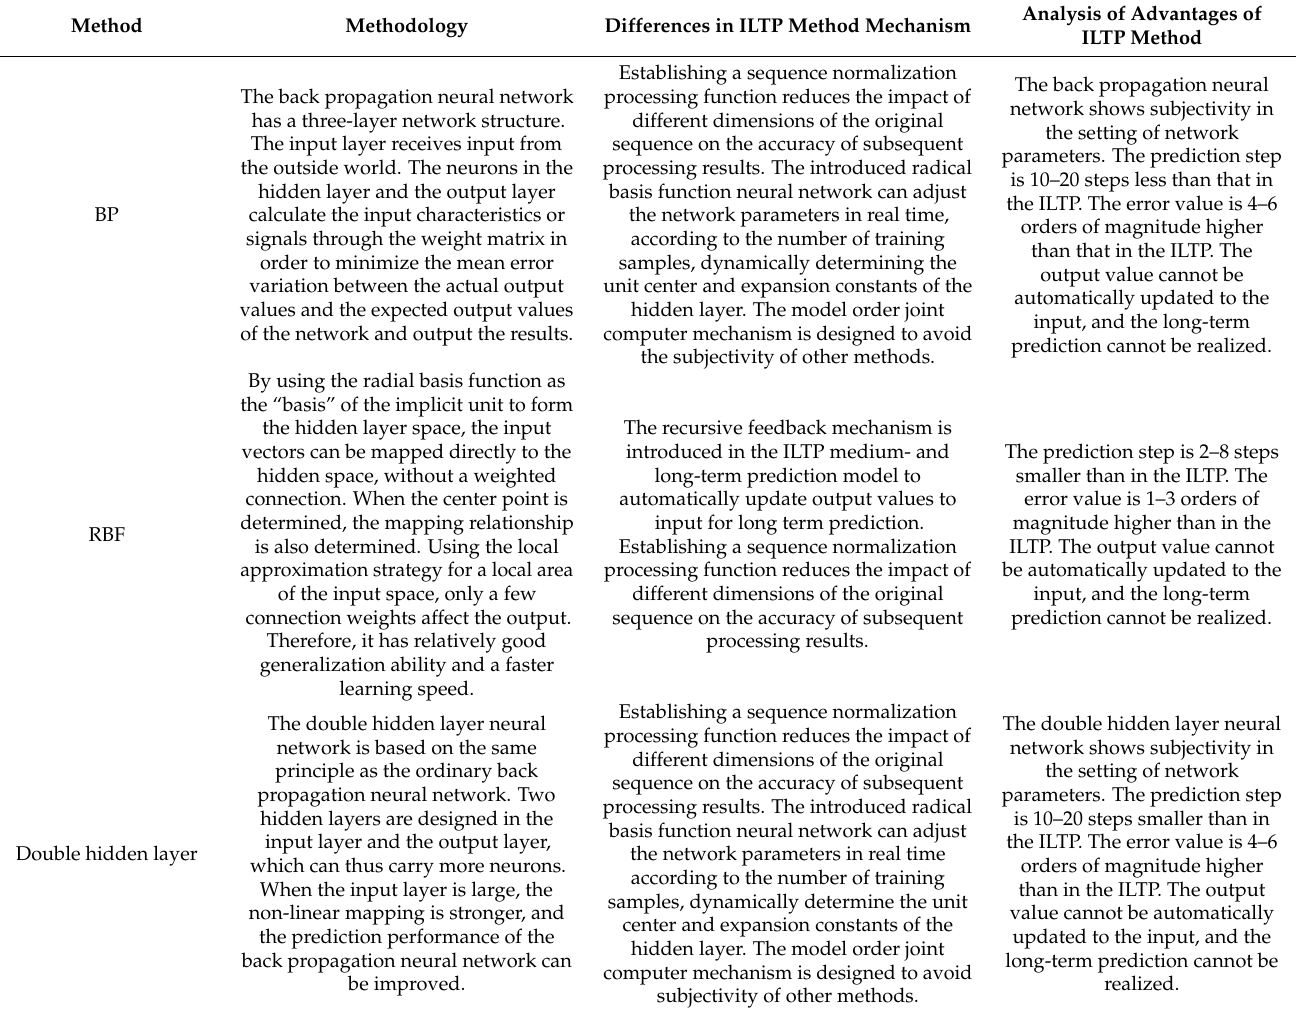
Table 5. Comparison of the ILTP method with other